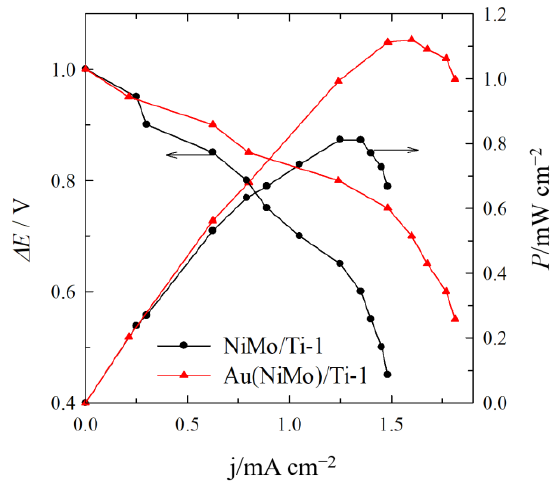
Figure 9. Cell polarization and power density curves for the C 6 H 12 O 6 -H 2 O 2 fuel cell using NiMo/Ti- 1 and Au(NiMo)/Ti-1 anode coatings with anolyte consisted of 0.1 M C 6 H 12 O 6 + 1 M NaOH and 5 M H 2 O 2 + 1.5 M HCl catholyte at 25 ◦ C.